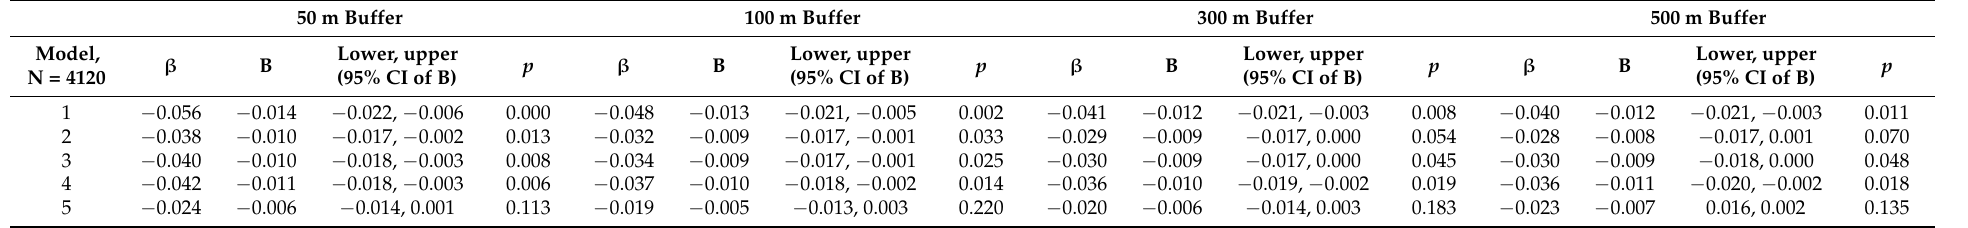
Table 3. Associations between residential greenspace at 50 m, 100 m, 300 m, and 500 m buffers, and depressive symptoms (subsample: non-working). 50 m